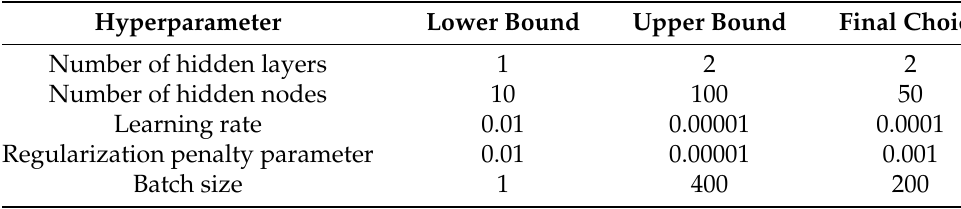
Table 1. DoE results for the hyper-parameters of the MLP model.